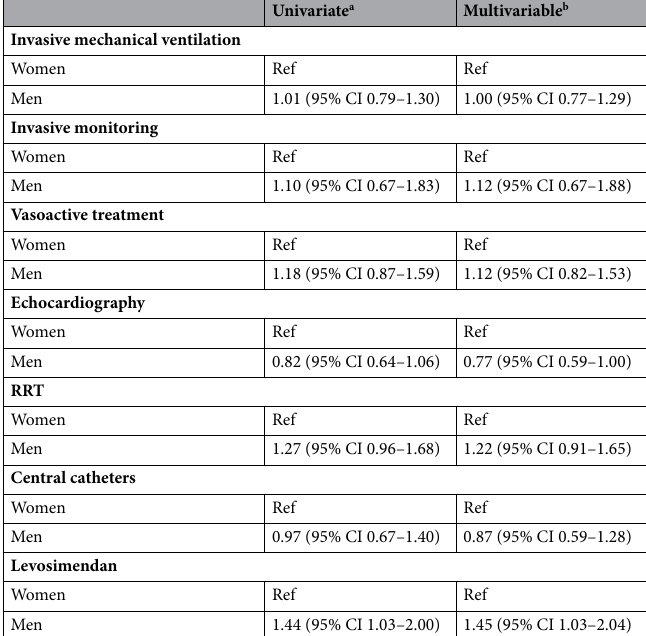
Table 3. Univariate and multivariate logistic regression analyses on patients admitted with sepsis, exploring differences in the use of invasive mechanical ventilation, invasive monitoring, vasoactive treatment, echocardiography, RRT and placement of central catheters, based on the sex of the patient. Data presented as odds ratio and 95% CI. a 1036 and 1007 patients are included in univariate analyses and multivariable analyses respectively. b Adjusted for Age, Estimated mortality risk and Charlson Co-morbidity index. RRT Renal replacement